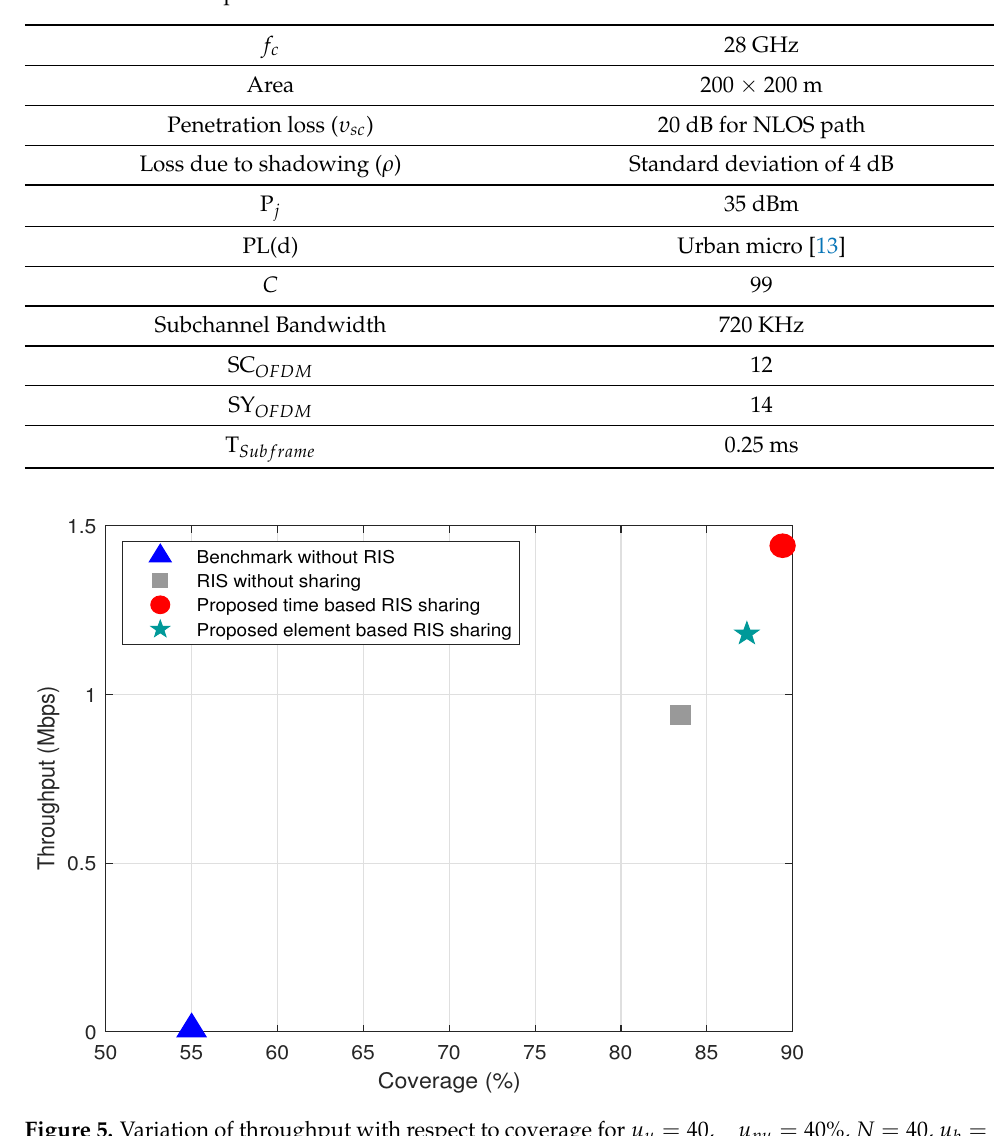
Table 2. Simulation parameters.